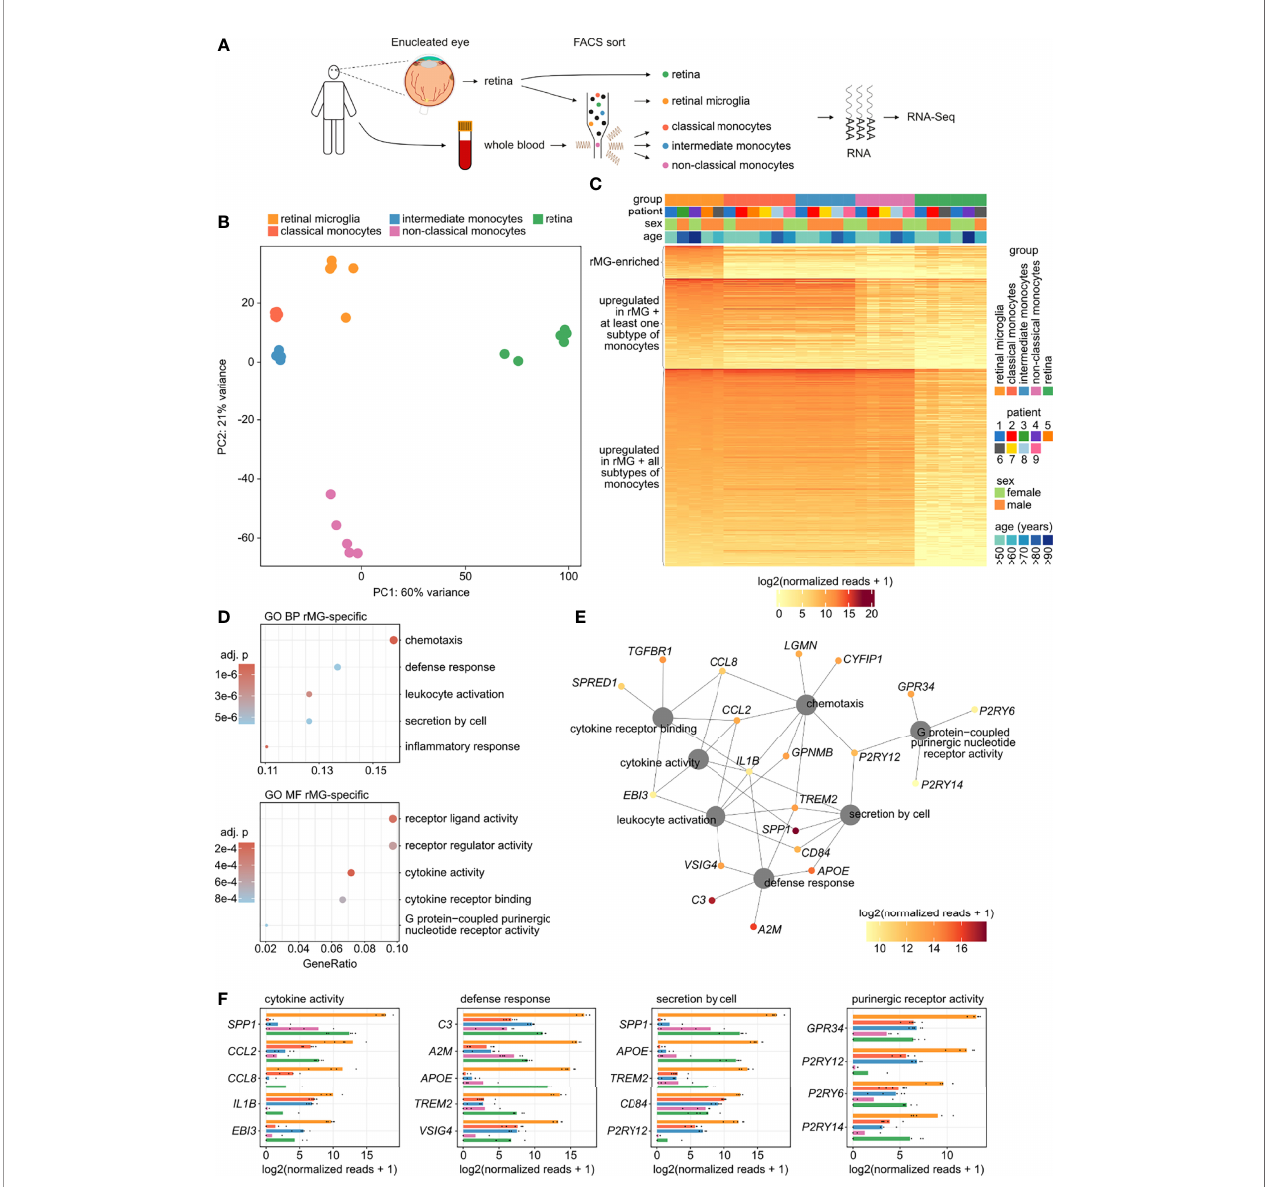
FIGURE 2 | Identi fi cation of human retinal microglia-enriched genes. (A) Experimental setup: retinal tissue was collected from six enucleated eyes and whole blood was obtained from six patients. Retinal tissue, retinal microglia (CD45 + CD11b + CX 3 CR1 + MatMac + CCR2 - ), as well as classical (CD45 + CD11b + CX 3 CR1 + CD14 ++ CD16 - ), intermediate (CD45 + CD11b + CX 3 CR1 + CD14 ++ CD16 + ), and non-classical monocytes (CD45 + CD11b + CX 3 CR1 + CD14 - CD16 ++ ) were isolated by fl uorescence-activated cell sorting (FACS) followed by RNA sequencing. (B) Principal component analysis (PCA) illustrating the clustering of the fi ve analyzed groups. (C) Heatmap visualizing the expression of 2,433 enriched genes in retinal microglia compared with retinal tissue (see Figure 1B top), grouped by genes that were also overexpressed in retinal microglia compared with all three subtypes of monocytes (n = 249, top of the heatmap), as well as those transcripts that were expressed at comparable levels in retinal microglia and at least one (n = 678, center of the heatmap) or all three subtypes of monocytes (n = 1,506, bottom of the heatmap). Groups and demographics are color- coded in the heatmap annotation at the top (see legend on the right). (D) Dotplots visualizing the top fi ve Gene ontology (GO) biological processes (BP) and molecular functions (MF), which the enriched genes in retinal microglia (rMG-enriched from C) were involved in. The GeneRatio represents the proportion of associated genes to the total number of enriched genes. The adjusted p-value of each GO term is shown by color. (E) Network diagram visualizing the rMG-enriched genes associated with the most signi fi cantly enriched GO biological processes and molecular functions. The color represents mean expression in rMG of each gene. (F) Bar graphs illustrating the top fi ve expressed genes in rMG associated to four of the most signi fi cantly enriched GO biological processes and molecular functions in rMG. The expression is also visualized for all three subtypes of monocytes as well as for retinal tissue. The lengths of the bars correspond to mean expression, while the black dots visualize expression in each